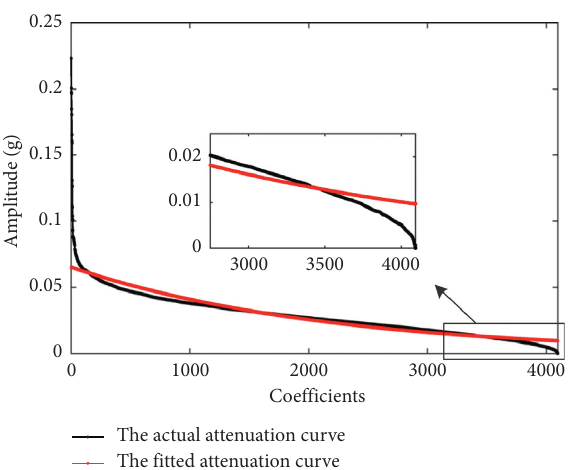
Figure 9: The fitting result of coefficients attenuation curve in Figure 8(b): SSE � 0.18; R -square � 0.852.